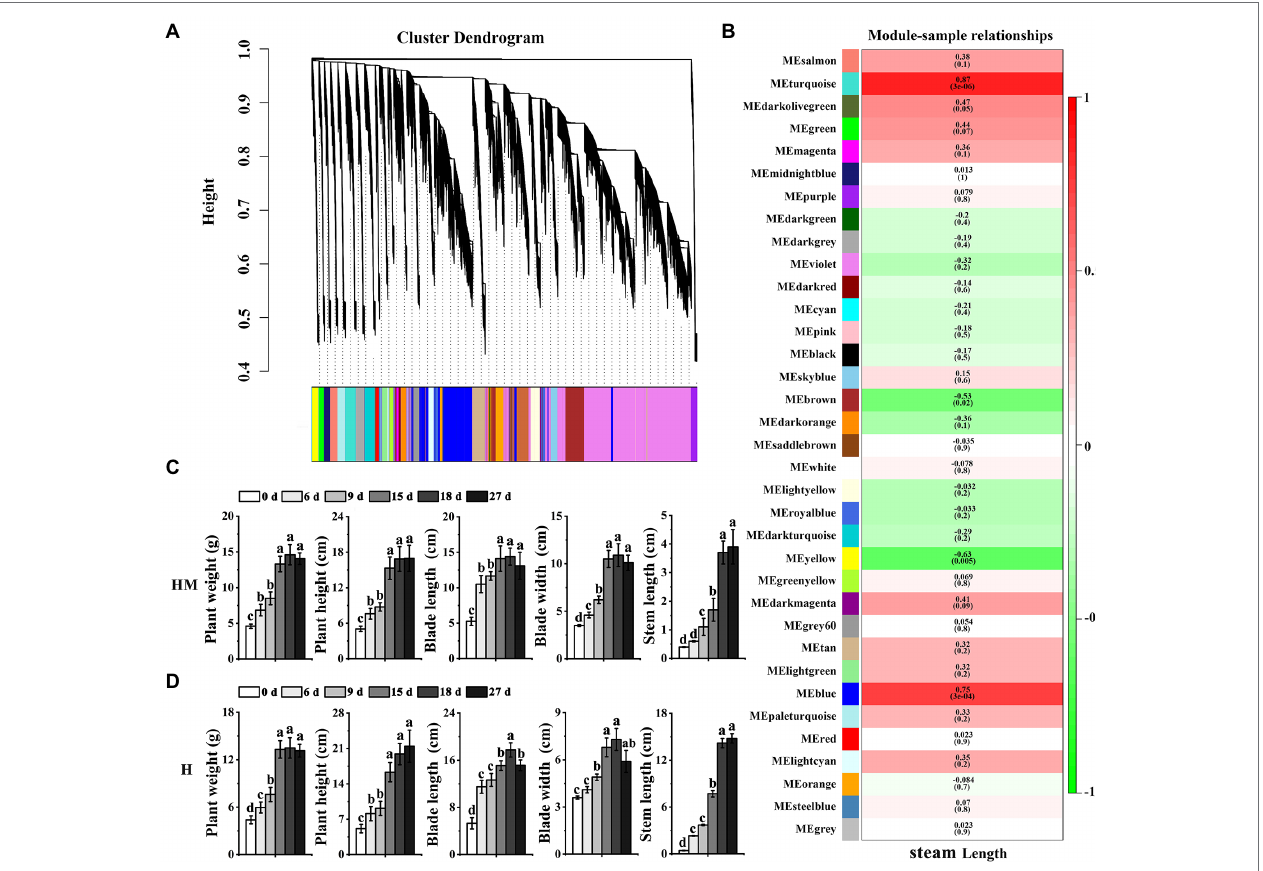
FIGURE 4 | Network analysis dendrogram showing modules identified by weighted gene co-expression network analysis (WGCNA). (A) Dendrogram plot with color annotation. (B) Module-bolting correlations and corresponding p values (in parentheses). The left panel shows the seven modules. The color scale on the right shows module trait correlation from 1 (green) to 1 (red). (C) The weight, height, blade length, blade width, and steam length of leaf lettuce in five developmental stages with exogenous melatonin at high temperature. “MH” represents 100 μ mol L − 1 melatonin treatment under high temperature. (D) The weight, height, blade length, blade width, and steam length of leaf lettuce in five developmental stages without exogenous melatonin at high temperature. “H” represents no exogenous melatonin treatment under high temperature. Different letters above the bars indicate significantly different values ( p < 0.05) calculated using one-way analysis of variance (ANOVA) followed by a Tukey’s multiple range